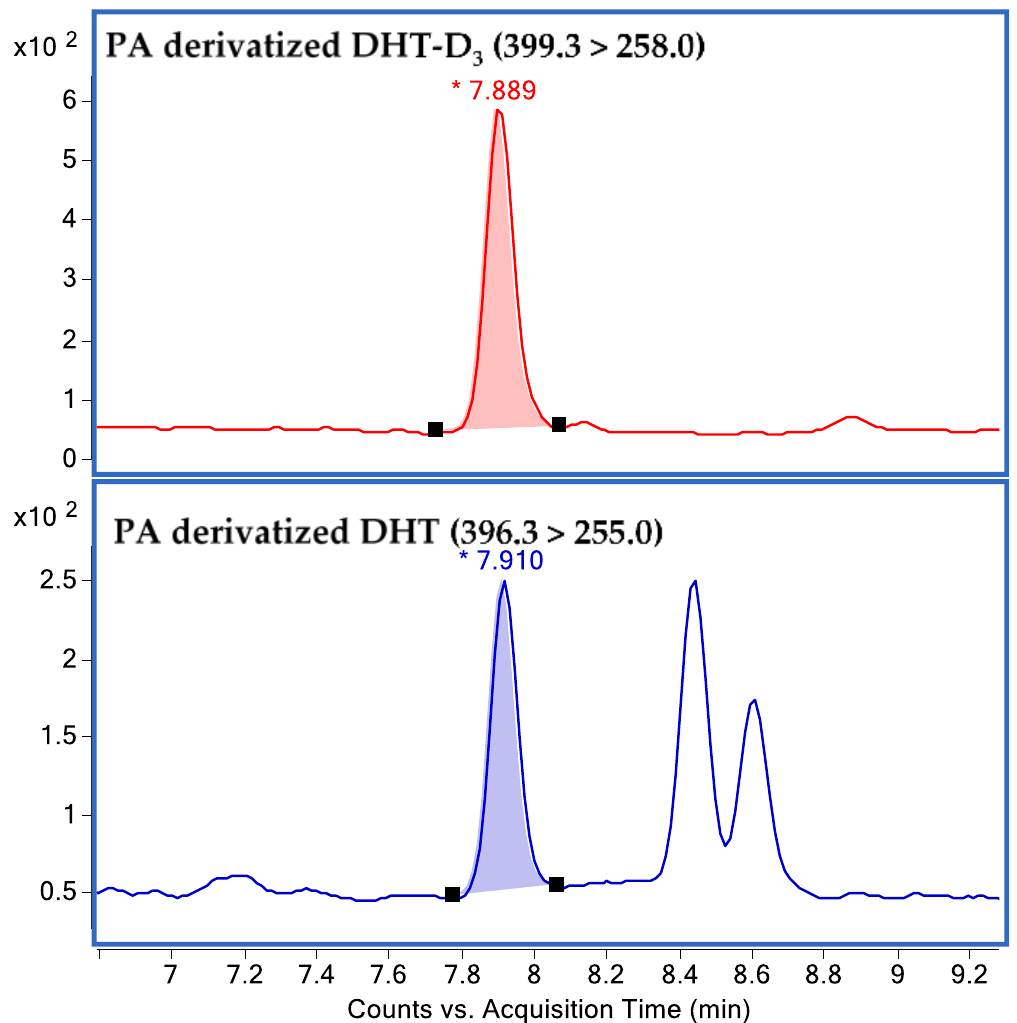
Figure 1. Chromatograms of 2-picolinic acid (PA)-derivatized 5- α dihydrotestosterone (DHT) and DHT-D3.